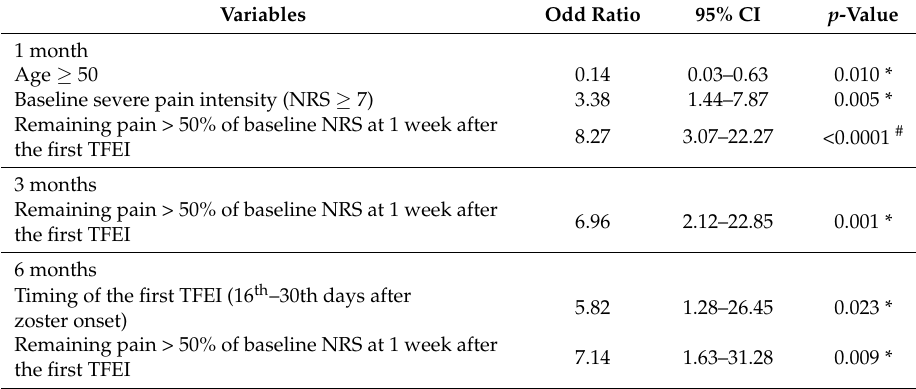
Table 3. Multivariate logistic regression analysis of independent risk factors associated with the development of